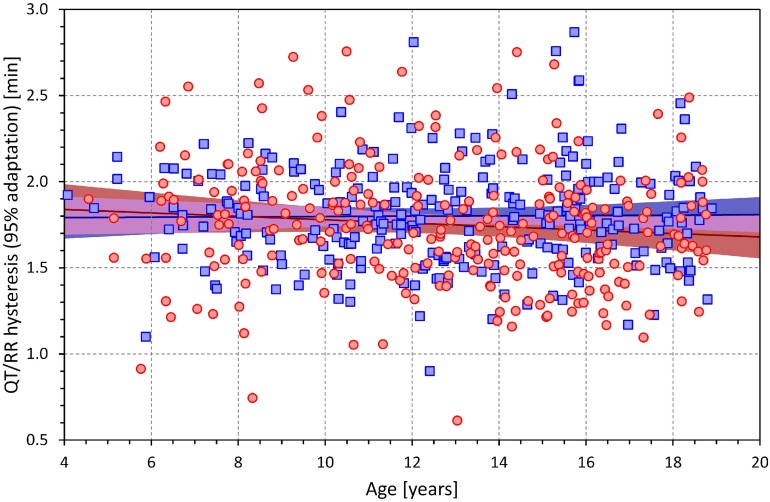
Age dependency of the intra-subject QT/RR hysteresis time constants (i.e., time intervals needed for 95% adaptation of QT interval duration after heart rate change). The layout and symbol definition are the same as in Figure 3.